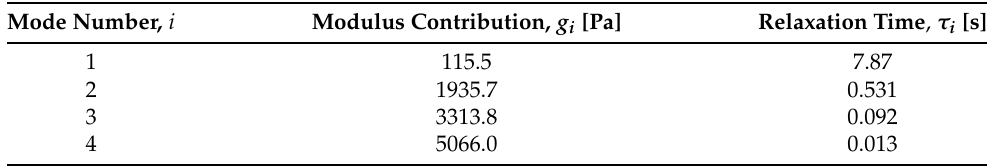
Table 3. Parameter values obtained by fitting the four-mode Maxwell model in Equations (18) and (19) to the elastic and viscous modulus shown in Figure 6b. Mode Number,